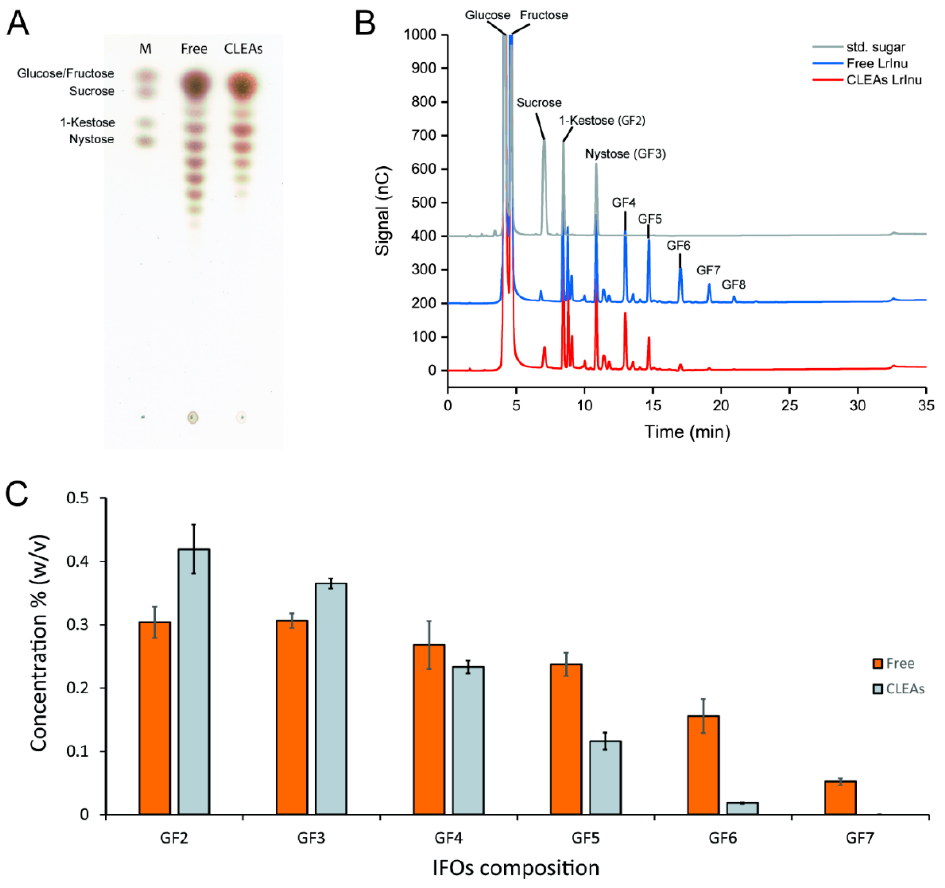
Figure 5. ( A ) TLC analysis of IFOs profiles synthesized by free and immobilized inulosucrase; lane